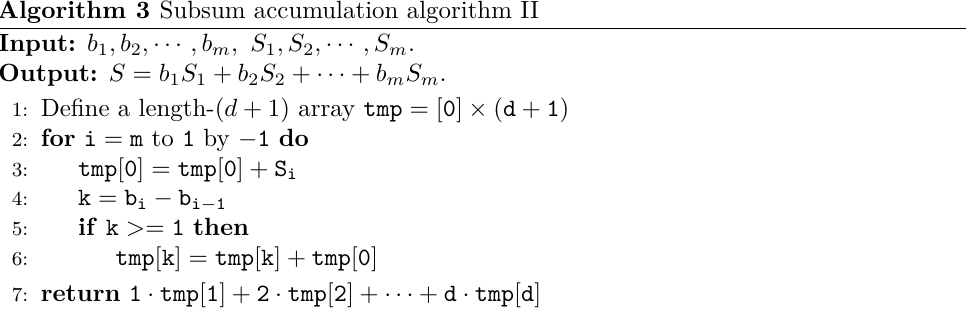
Algorithm 3 Subsum accumulation algorithm